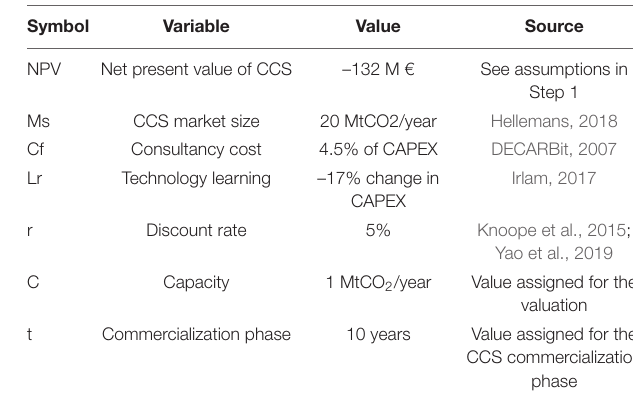
TABLE 2 | Parameters of net present value and option valuation model in step 1. TABLE 3 | Additional parameters for option valuation in step